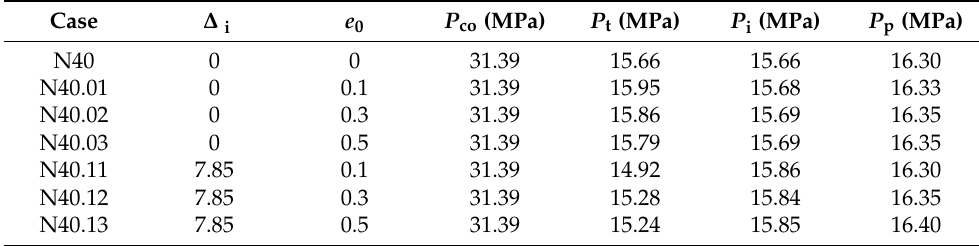
Table 5. The initial imperfection of the inner pipe.